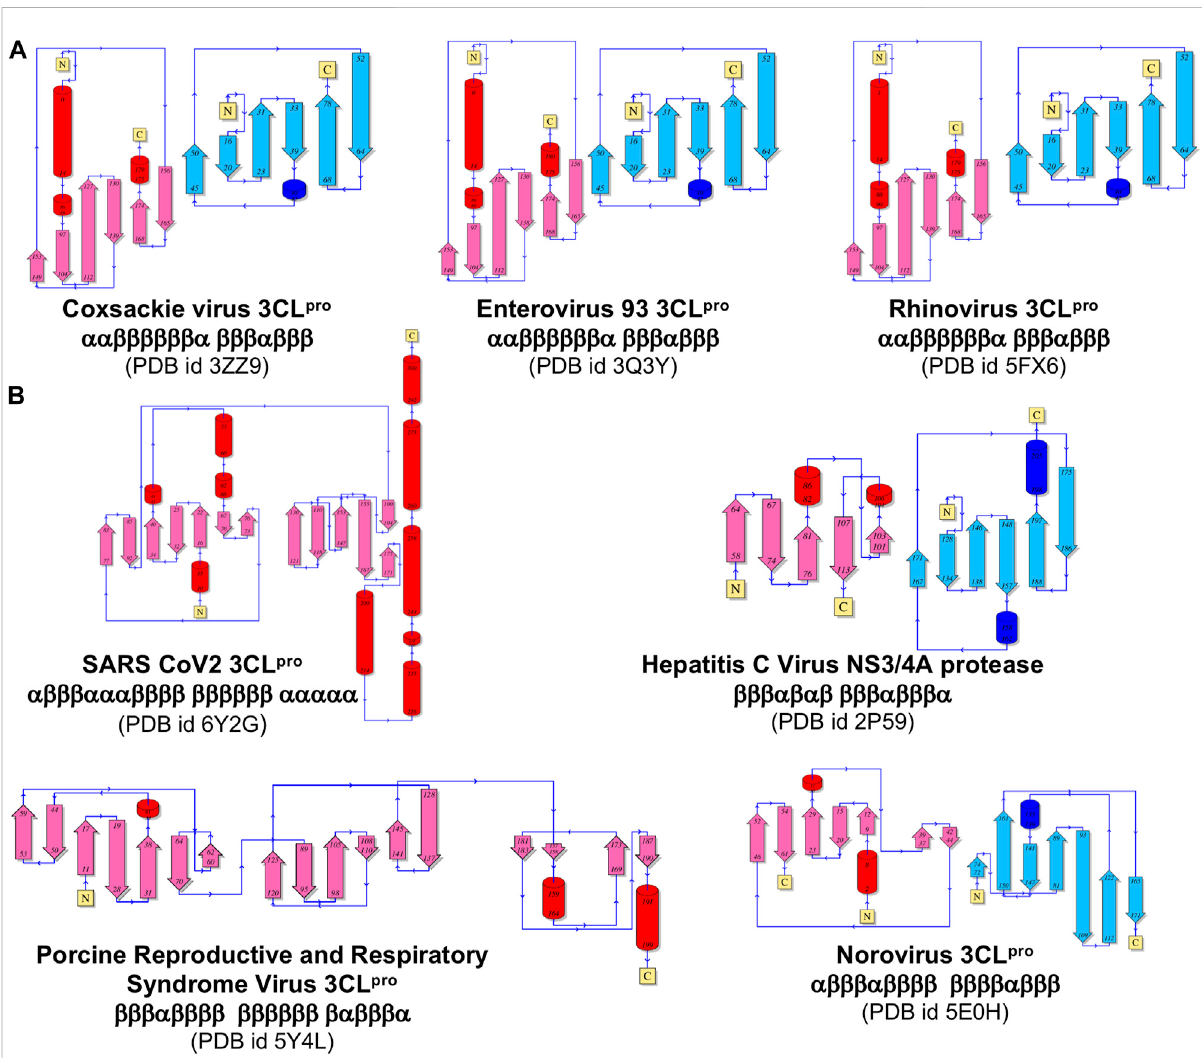
FIGURE 5 Comparisonoftopologicalrepresentationofsecondarystructuralelementsofviralprotease. (A) Topologyofproteasesofthevirusesbelonging to the same Picornaviridae Family. (B) Topology of proteases from different Families listed in Figure 3. ⍺ -Helices are represented as cylinders and β - sheets are represented as arrows. These topological diagrams were obtained from PDBsum (http://www.ebi.ac.uk/pdbsum) (Laskowski et al., 2018), with the indicated PDB id for each